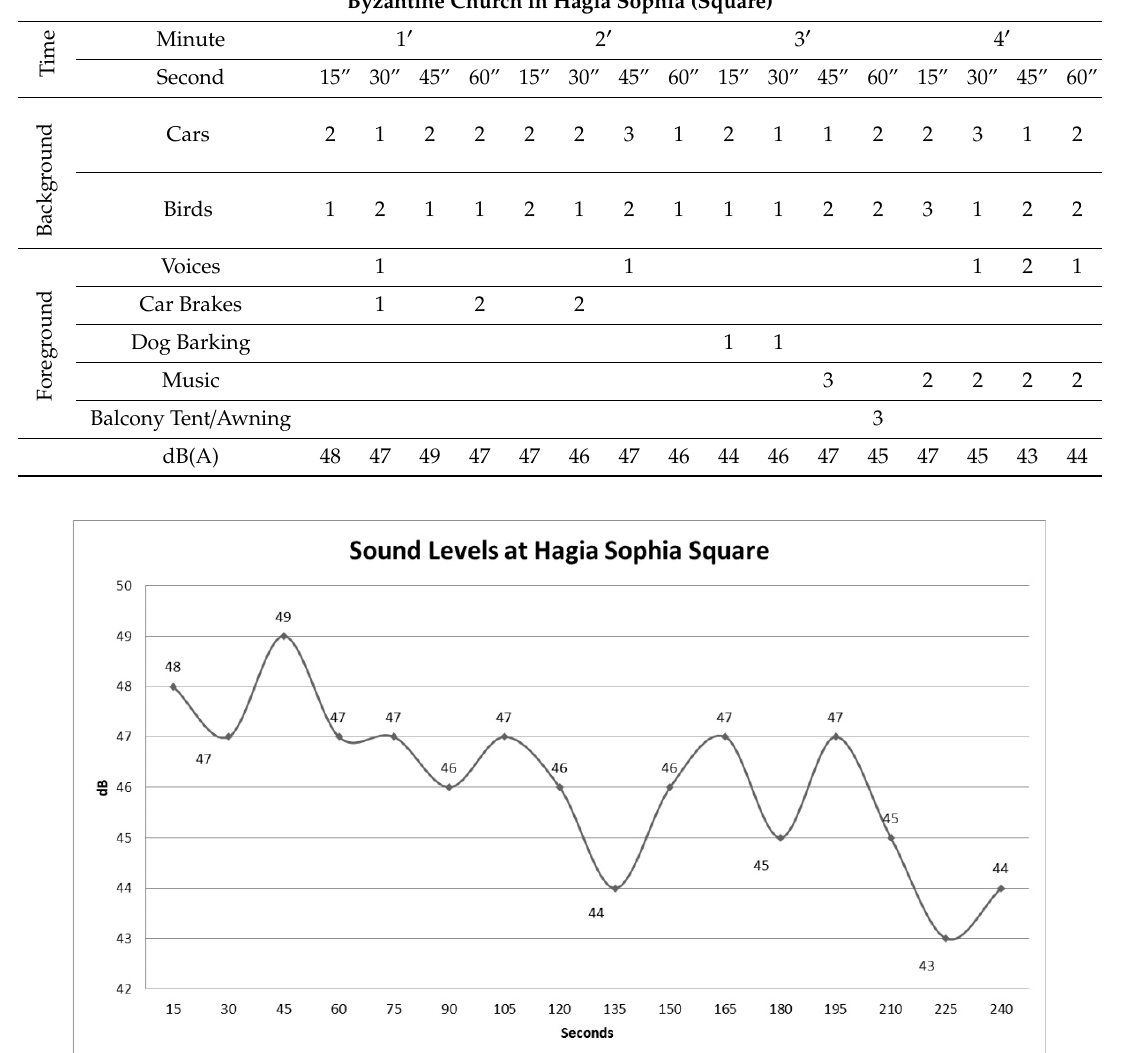
Figure 6. A graph showing levels of noise (dB) in Hagia Sophia Square.